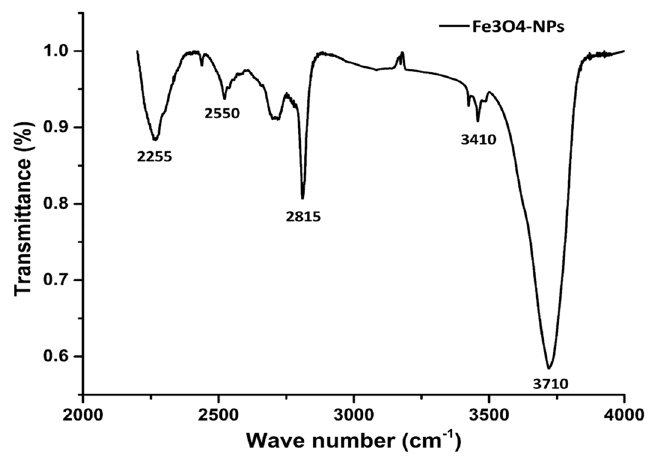
Figure 10. FTIR spectral analysis of the biofabricated Fe 3 O 4 -NPs.